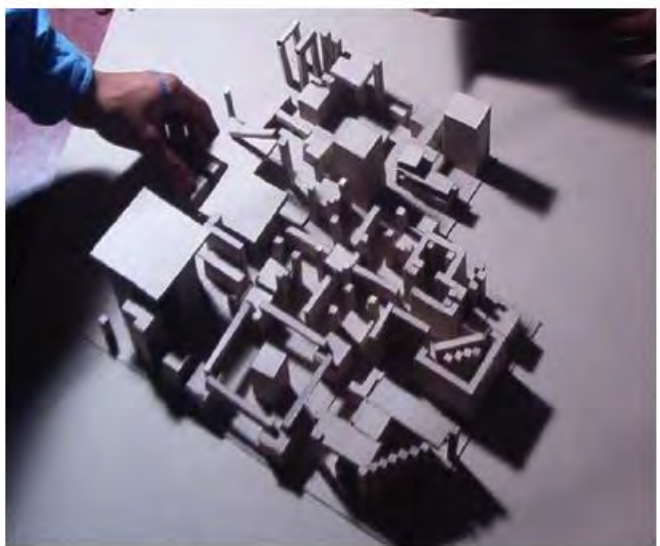
Figure 5. Design students working on a traditional kit of parts project